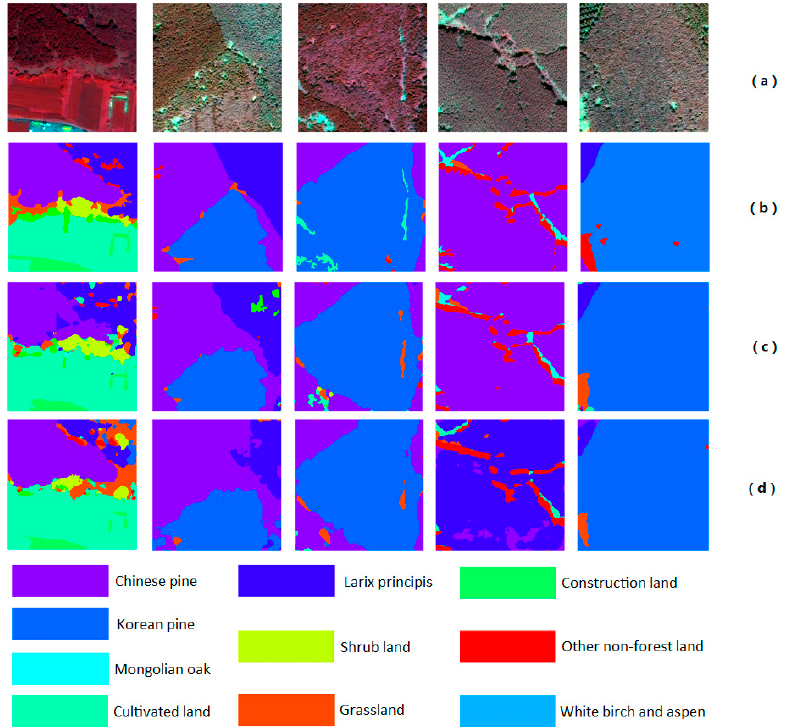
Figure 9. The detailed information of the results with two decoder fusion strategies of the Wangyedian forest farm ( a ) GF-2; ( b ) label; ( c ) dual-uNet-Resnet; ( d ) dual-uNet-Resnet-DeMerge. 4.3. Impact of Inserting the Convolution Module into the Skip Connection One of the major components of the uNet model is the skip connection. The research investigated the classification impact of adding the residual convolution module (dual-uNet-Resnet), ordinary convolution module (dual-uNet-Resnet-ConvConnect), and without any convolution module (dual-uNet-Resnet-WithoutConnect) in the skip connection to validate the effect of adding the convolution module of different architectures in the skip connection. According to Table 7, the classification accuracy significantly improved as the complexity of the convolution module increased. First, the overall classification accuracy was raised from 91.01% to 93.30%. This trend has also been shown by the optimization effects of Larix principis, Cultivated land, Construction land, Shrub land, and Grassland. As shown in Figure 10, the classification accuracy increased following the addition of the residual convolution module, particularly in areas with several categories. Table 7. Impact of inserting the convolution module into the skip connection. Dual-uNet-Resnet Dual-uNet-Resnet-ConvConnect Dual-uNet-Resnet-WithoutConnect